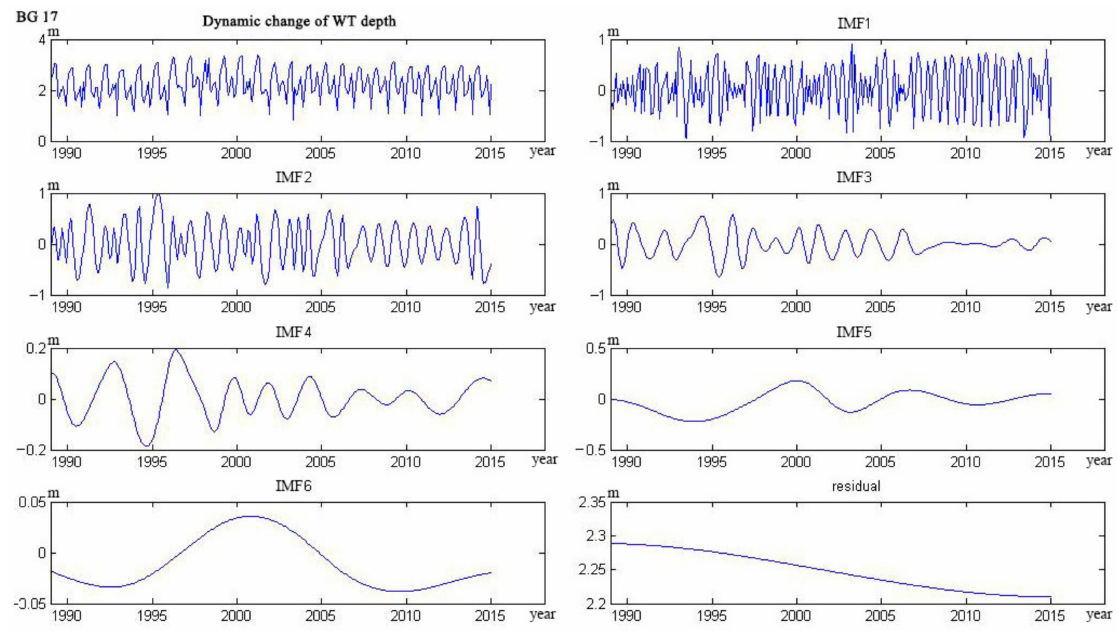
Figure A13. Decomposition of groundwater time series data of well BG17. Water 2017 , 9 , 864